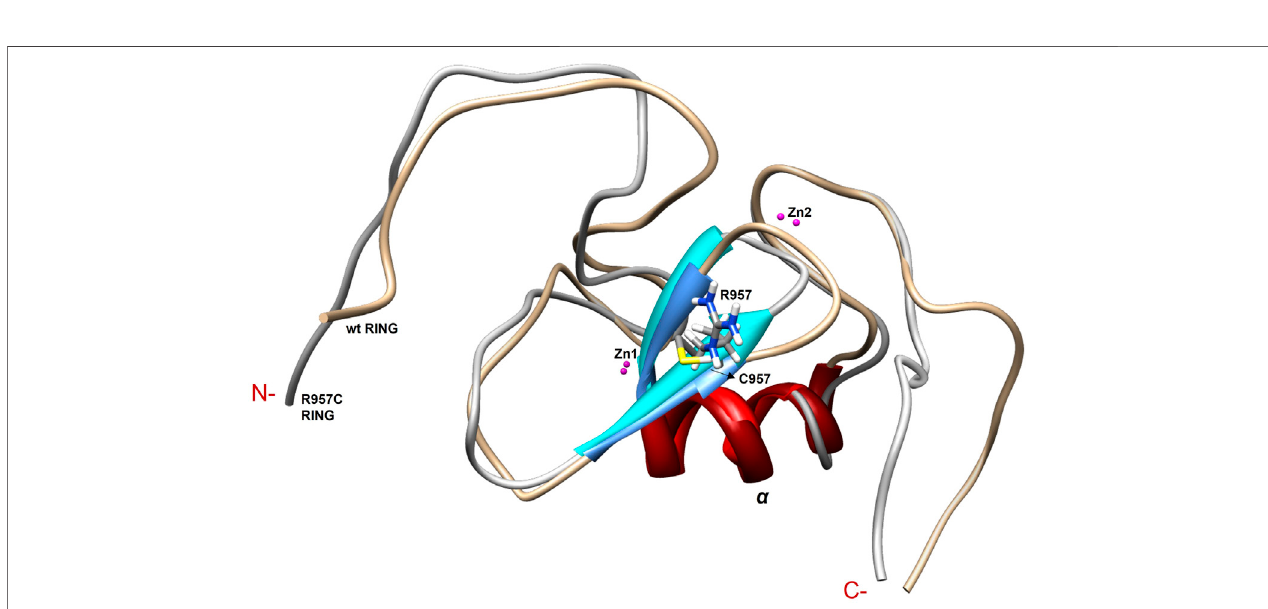
FIGURE 9 | Overlay of the fi rst model of the NMR family models of wt and R957C mutant of Arkadia RING.